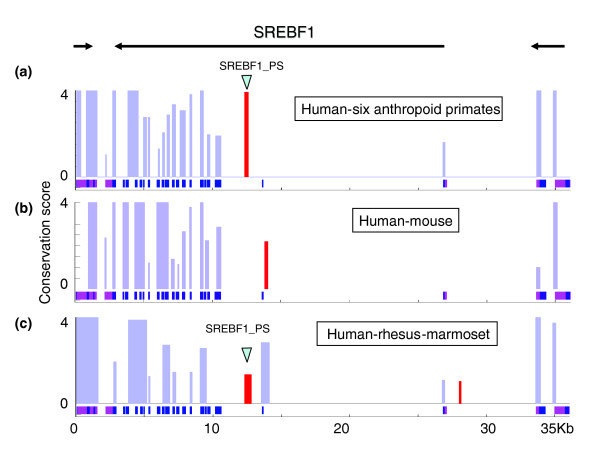
Conservation profiles of a representative region, the SREBF1 locus, using close (primate) and distant (human-mouse) species comparisons. (a) Seven-primate (human, baboon, colobus, marmoset, dusky titi, owl monkey, and squirrel monkey), (b) human-mouse, and (c) three-primate (human, rhesus, and marmoset) conservation profiles in the SREBF1 locus with flanking genes partially shown. Sequence conservation was calculated using Gumby and visualized using RankVISTA with the human sequence as reference. Vertical bars above the horizontal axis depict evolutionarily conserved sequences, with height indicating the conservation score (-log(conservation p value); see Materials and methods). Coding exons (dark blue) and untranslated regions (UTRs; magenta) are marked below the horizontal axis. Vertical bars that overlap coding exons or UTRs are colored light blue, while non-overlapping bars are colored red. The arrowhead denotes SREBF1_PS, a non-coding element conserved in primates (p value ≤ 0.005) but not in the mouse (p value > 0.1).